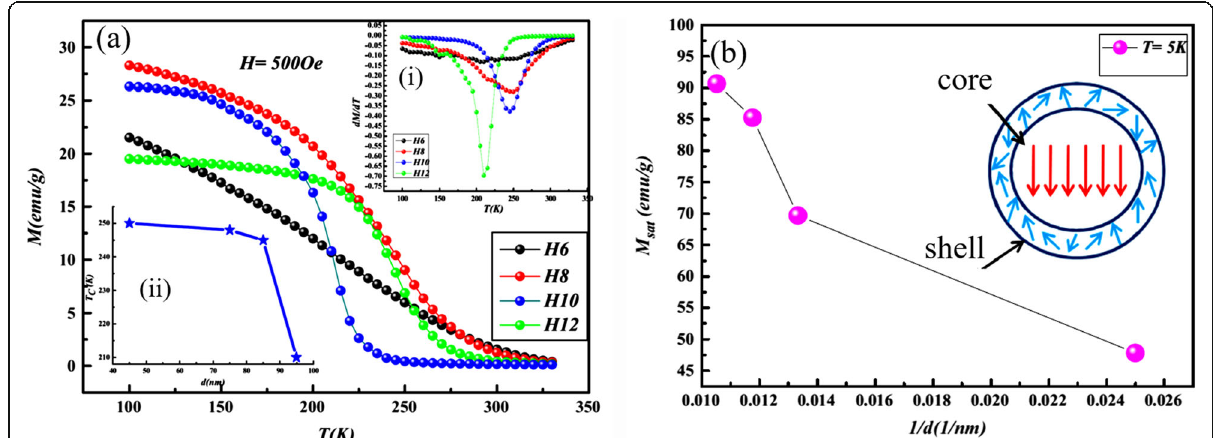
Fig. 19 a Temperature dependence of magnetization in the La 0.9 Sr 0.1 MnO 3 samples. Insets: (i) the dM/dT vs. T plots, and (ii) dependence of T C on the average of grain size ( d ). b Saturation magnetization M sat values versus the inverse of the crystallite sizes (1/ d ). Insert in ( b ) is a schematic diagram of the core-shell model for ferromagnetic nanoparticle. Reproduced with permission [148]. Copyright 2014, Elsevier Ltd and Techna Group S.r.l